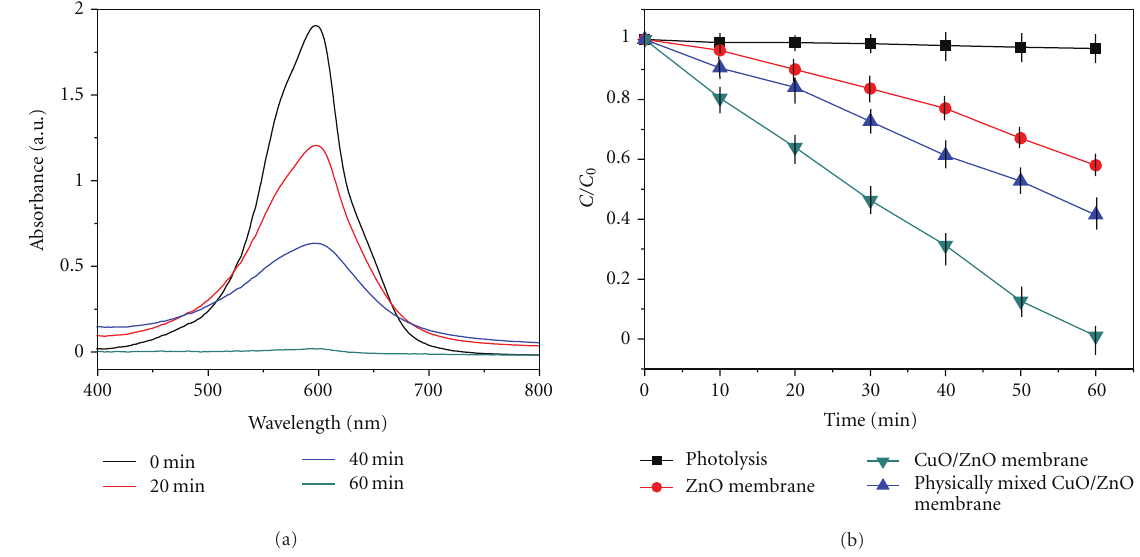
Figure 7: (a) The absorption spectra of MB solution under the irradiation of visible light on the CuO/ZnO membrane, and (b) the concentration change of MB solution under the irradiation of visible light on the CuO/ZnO membrane and ZnO